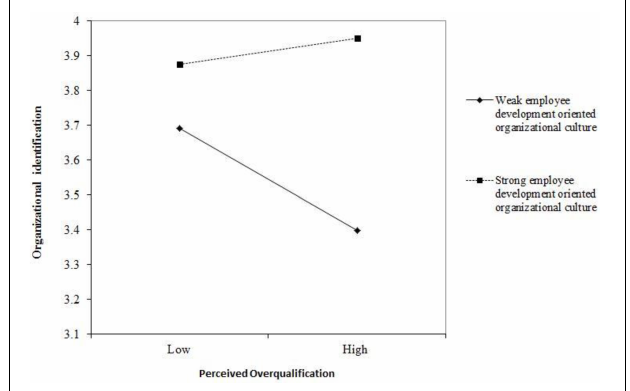
FIGURE 2 | Employee development-oriented organizational culture moderates the relationship between perceived overqualification and organizational